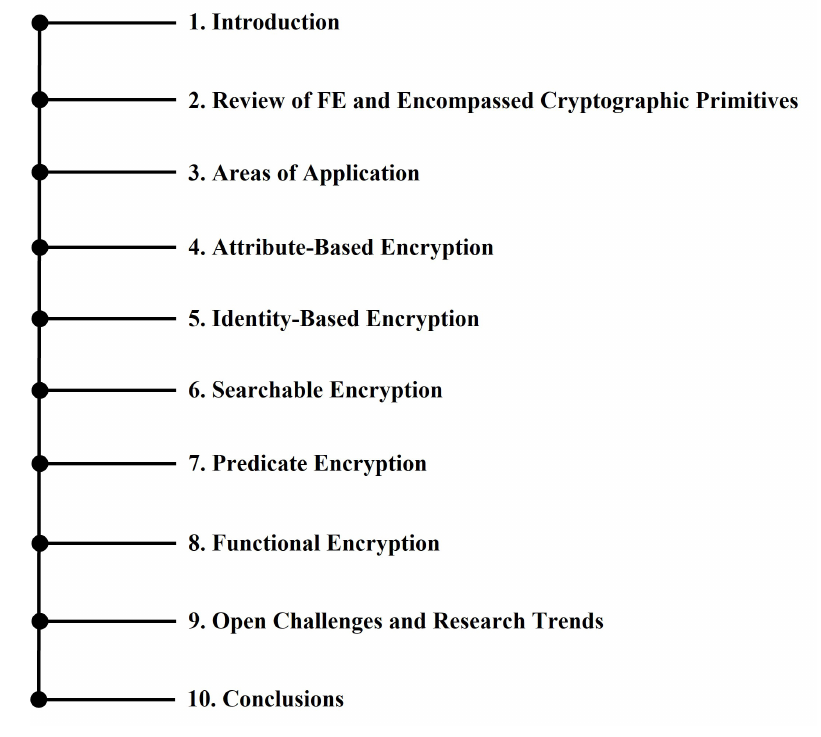
Figure 4. Outline of this